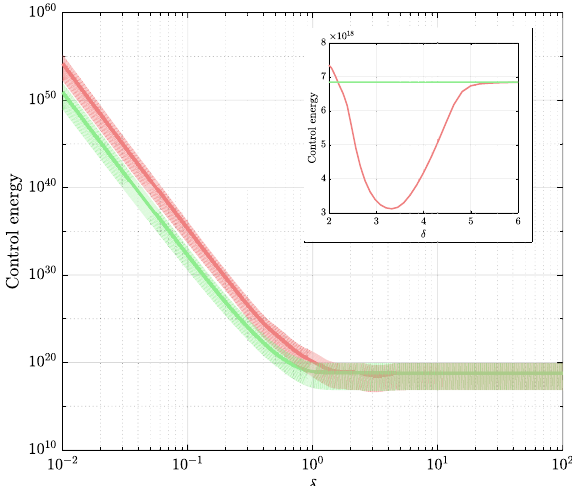
Figure 2. The advantage of temporal networks in the stochastic scenario. The solid lines represent the minimum expected energy averaged over all possible final states on the unit hypersphere centered in the origin W − 1 W − 1 (trace of E , in red) and the benchmark energy (trace of E , in green) as a function of σ exp δ = ( t m − t 0 )/ m . The shaded areas are enclosed by the minimum and the maximum J (cid:30) (cid:31) temporal ∗ (in red) and (cid:30) (cid:31) 5 final states on the unit hypersphere. In the fast regime (i.e., for small δ ), J static ∗ (in green) observed over 10 uncertainty prevails over temporality with the expected energy required to control a temporal network being larger than the benchmark energy. As temporality vanishes (i.e., for large δ ), the energy difference becomes negligible. The advantage of temporality appears in the intermediate temporality regime and is shown in the